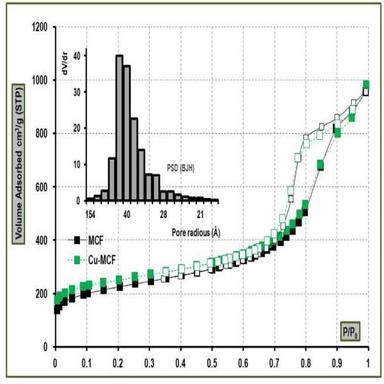
N2 adsorption isotherms at 77 K of MCF and Cu-MCF mesoporous ordered materials. In the case of Cu-MCF material the isotherm has been offset by a factor of 1.8 (the original Cu-MCF isotherm is presented in.